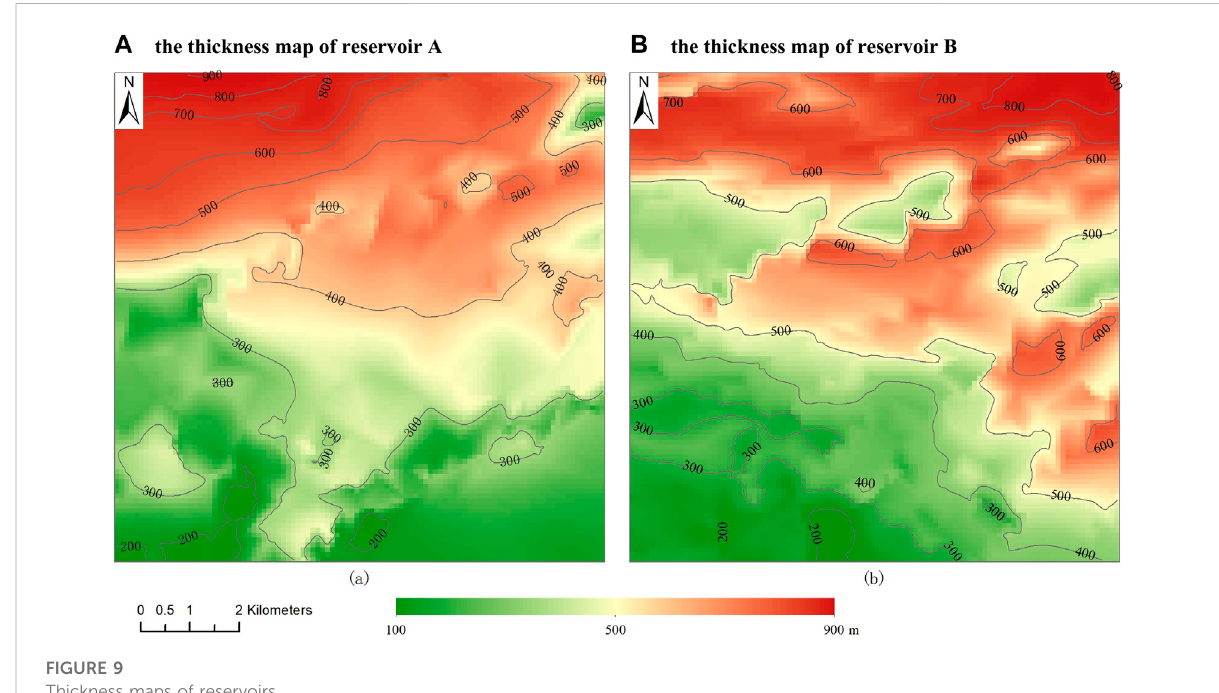
FIGURE 9 Thickness maps of reservoirs.